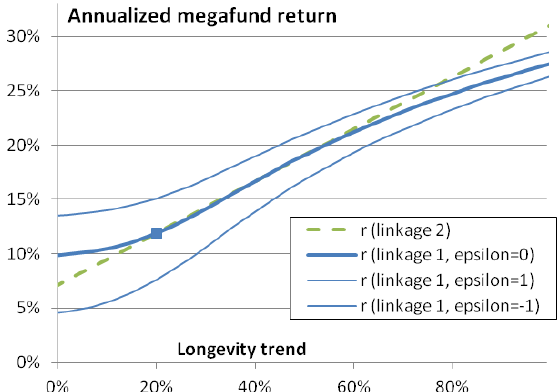
Figure 3. Megafund annualized return 𝑟 as a function of longevity trend φ . The square represents the central scenario with a future longevity trend of 20% and an annualized return of 11.9%. If the megafund target a very wide variety of pharmaceutical developments, returns are expected to depend on the longevity trend as show by the continuous (blue lines; the thick line is the best estimate, the thin lines represent a range of uncertainty): “linkage 1”. If the megafund targets mortality-linked diseases, the expected link with longevity is the (green) dashed line.